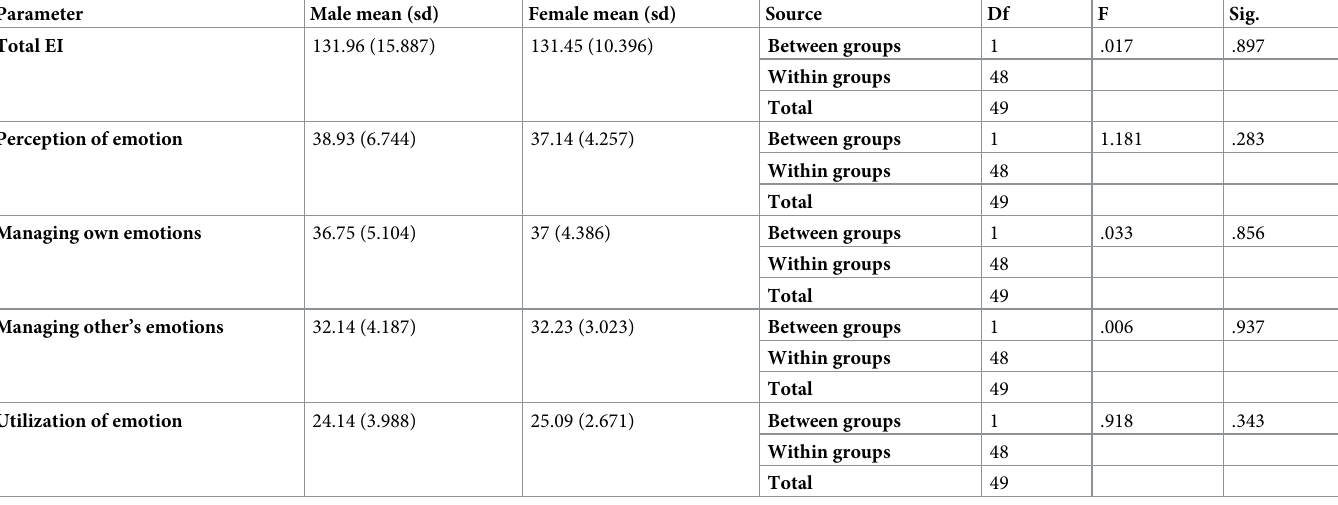
Table 2. ANOVA for SSEIT scores of males and